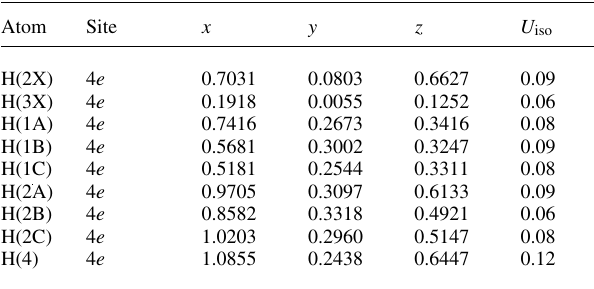
Table 2. Atomic coordinates and displacement parameters (in Å 2 )